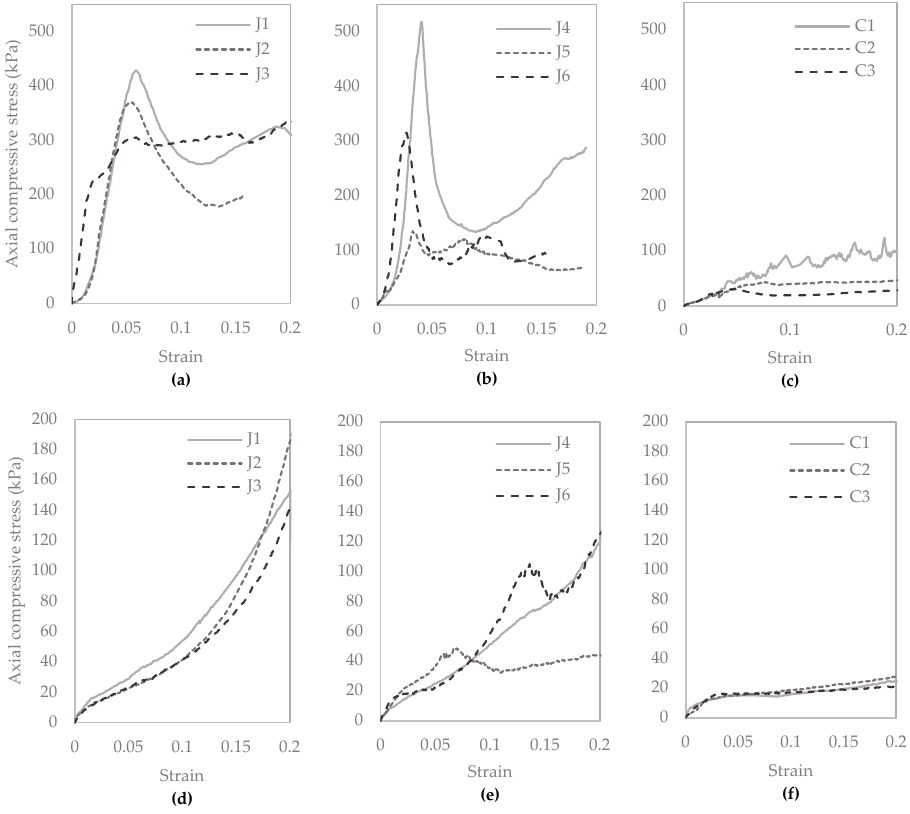
Figure 10. Unconfined compression test results following CM treatment five ( a – c ), and after reconstitution, flushing and saturation with water and eight days curing to test for self-healing ( d – f ).